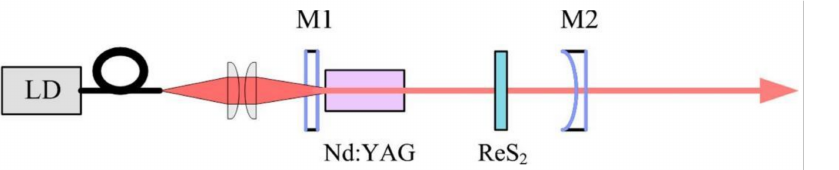
Figure 6. The schematic of Q-switched laser cavity based on ReS 2 SA. M1: plane input mirror; M2: concave output mirror with radius of − 100 mm and 8% transmittance [52].